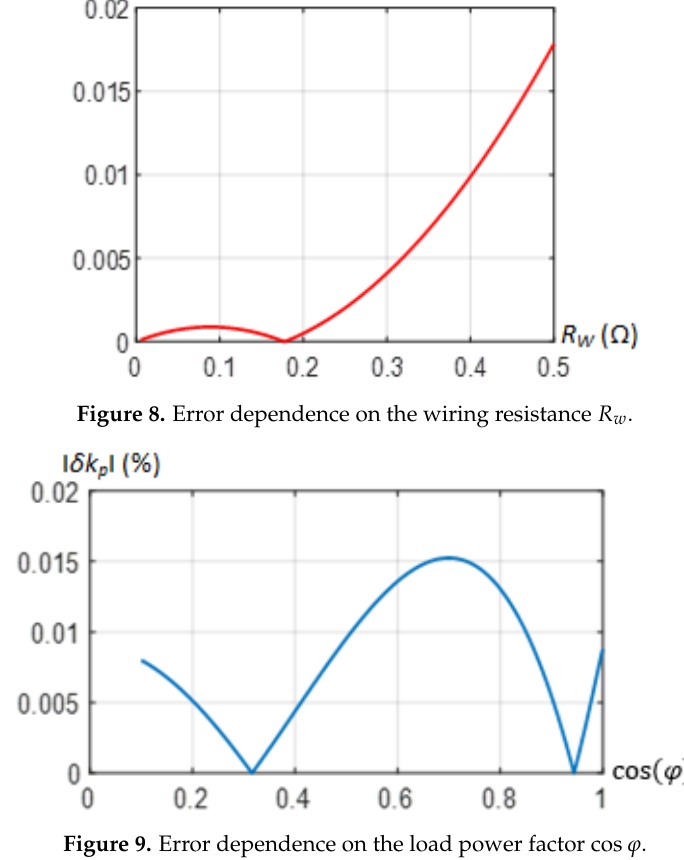
Figure 9. Error dependence on the load power factor cos 𝜑 .